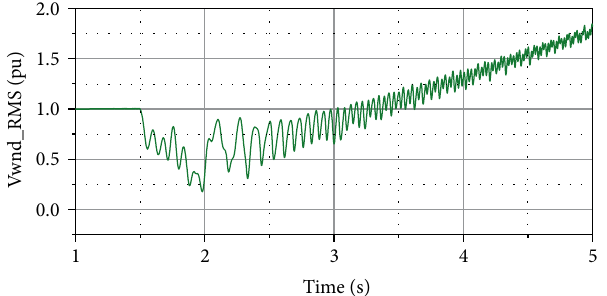
Figure 3: The wind farm machine terminal AC voltage characteristics.